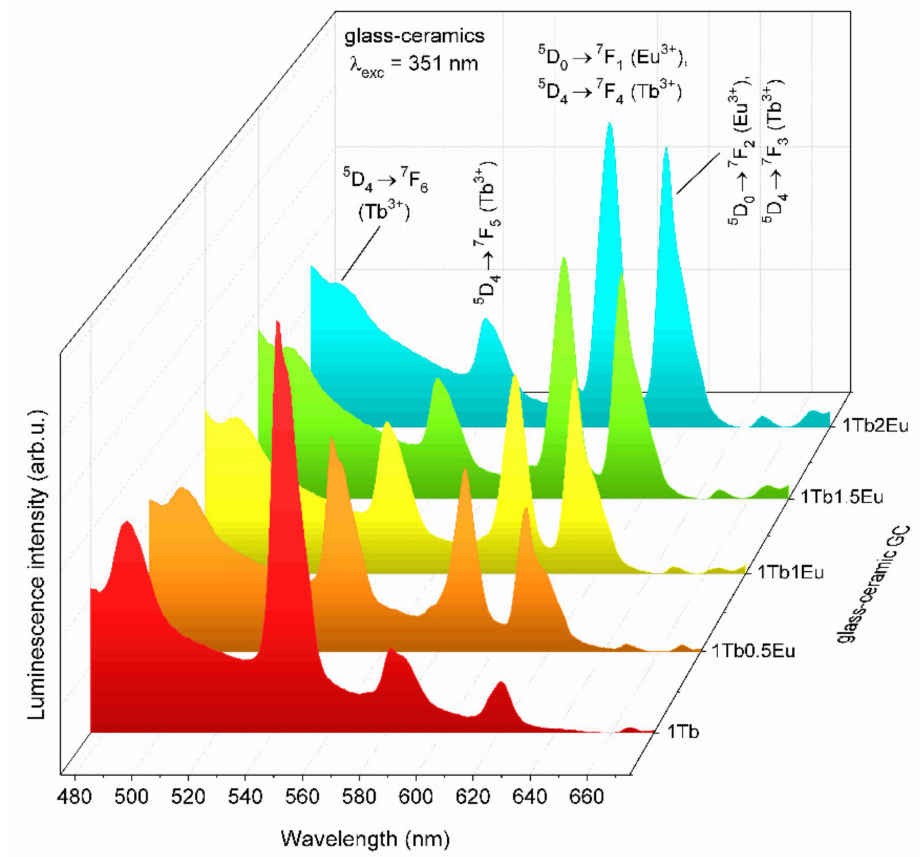
Figure 10. The emission spectra of GC 1Tb and GC 1TbxEu xerogels recorded under excitation at λ exc = 351